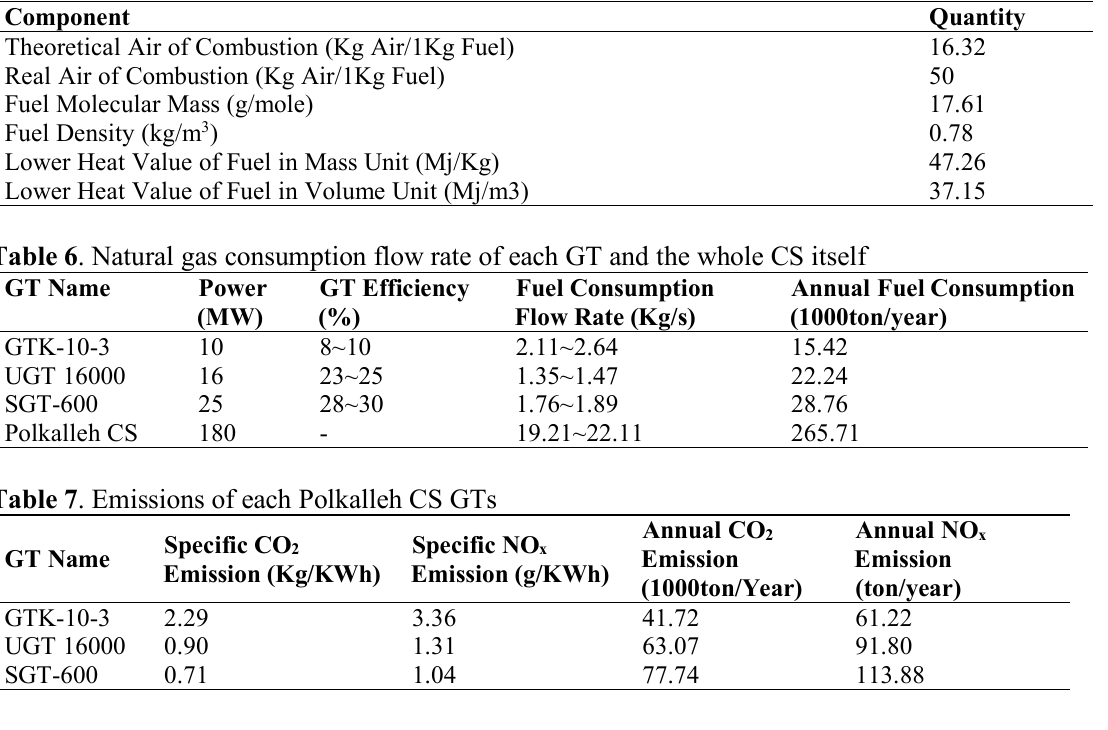
Table 5. Chemical components of natural gas in Polkalleh CS